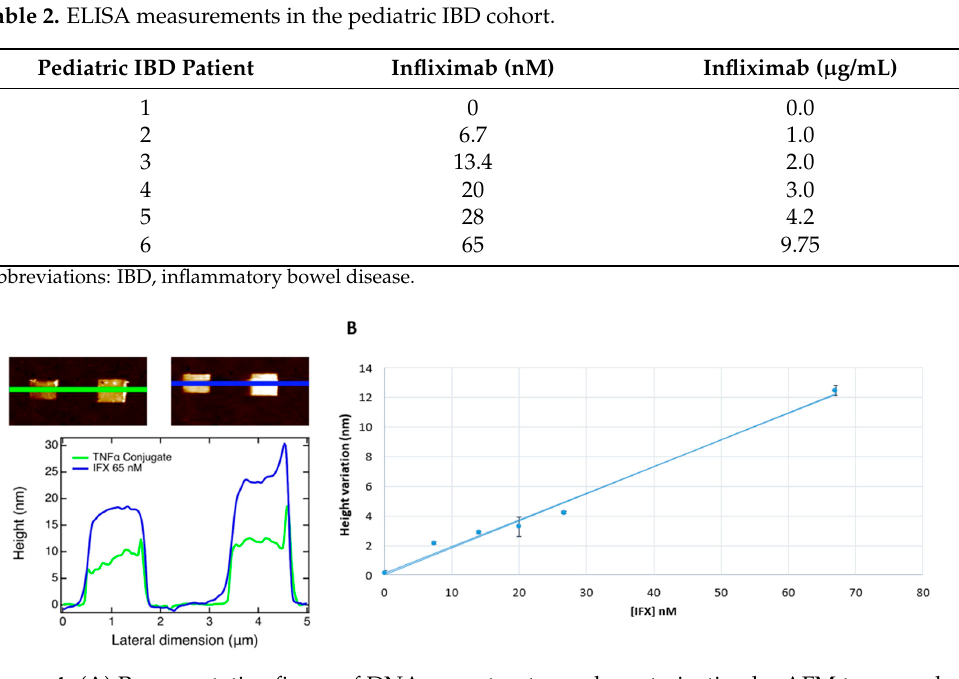
Figure 4. ( A ) Representative figure of DNA nanostructures characterization by AFM topography: different DNA patches profiles with different height taken from AFM images (green line: TNF-cF9 conjugate; blue line: IBD patient serum containing infliximab at a concentration of 65 nM); ( B ) calibration line obtained in six pediatric patients’ sera.